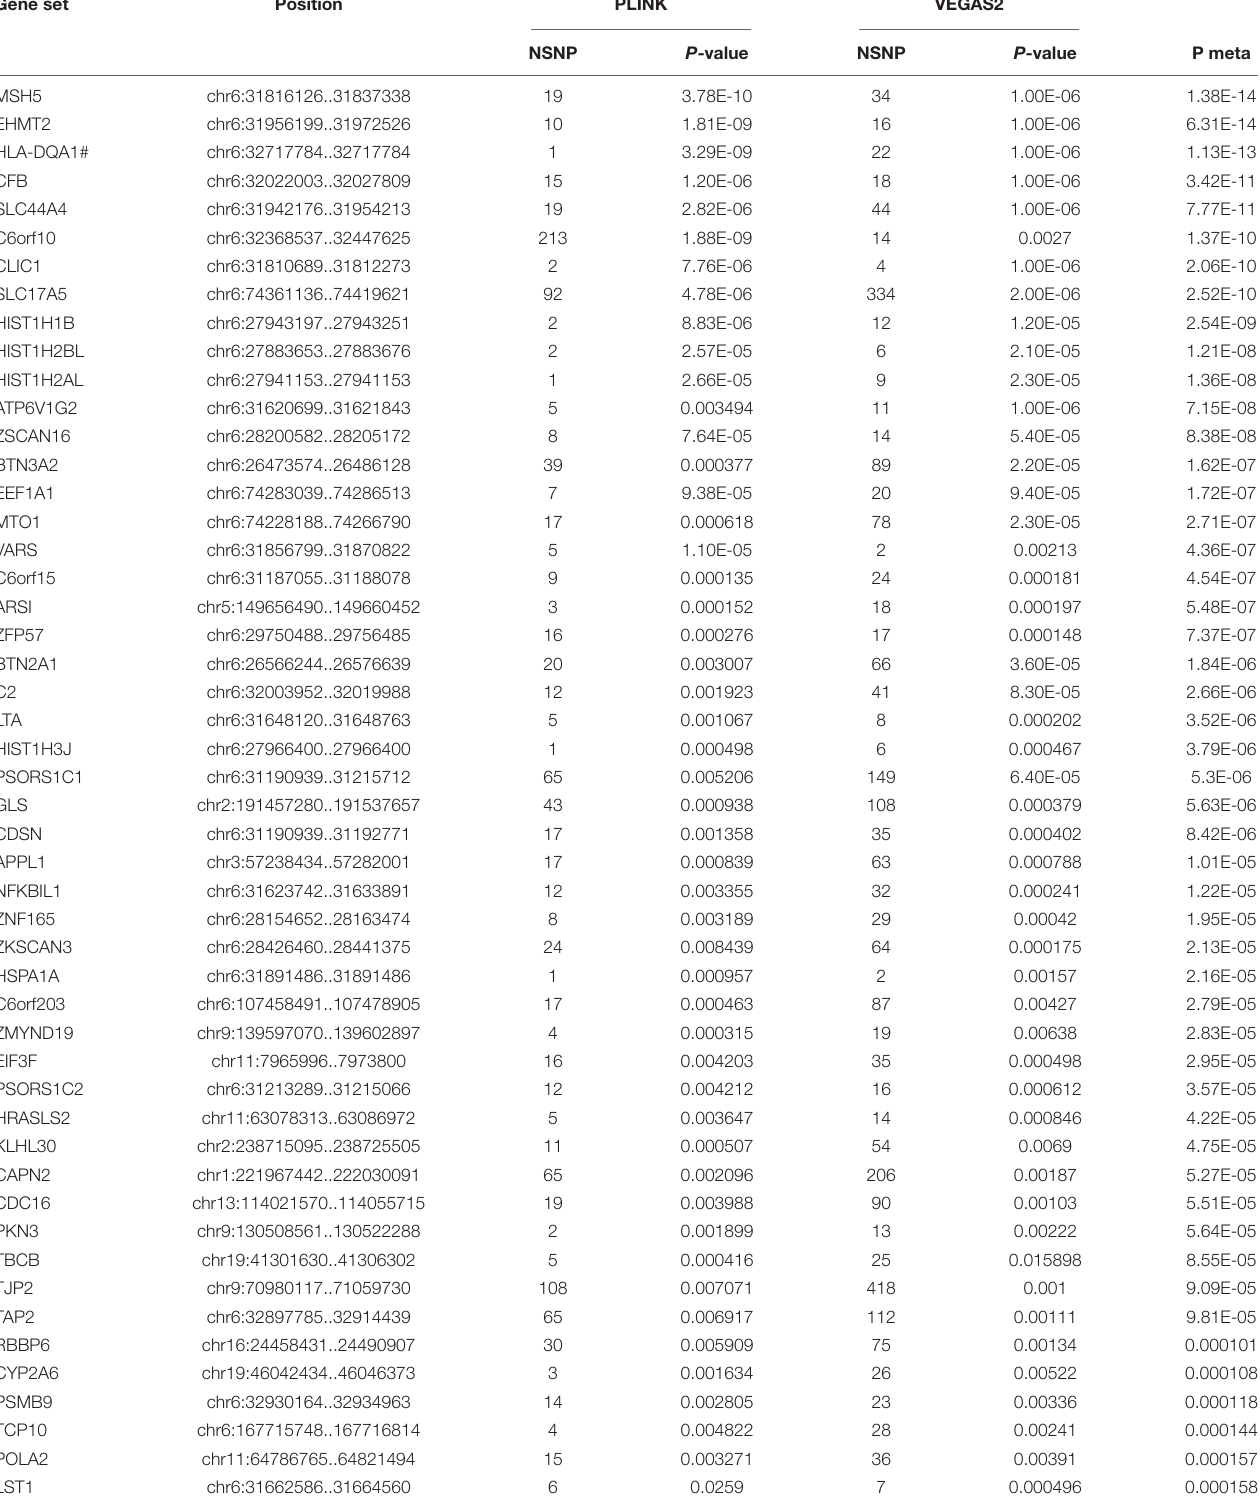
TABLE 2 | Comparison of significant shared gene sets in AQP4-positive NMOSD produced with VEGAS2 and PLINK. Gene set